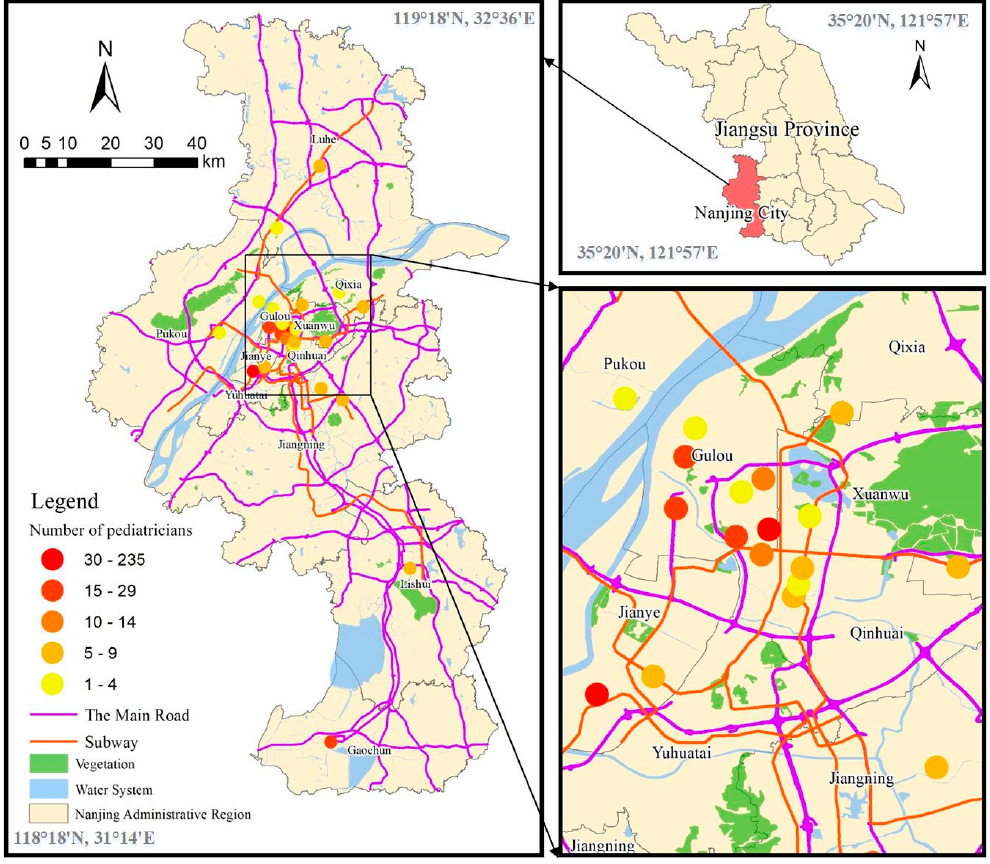
Figure 6. The study area.